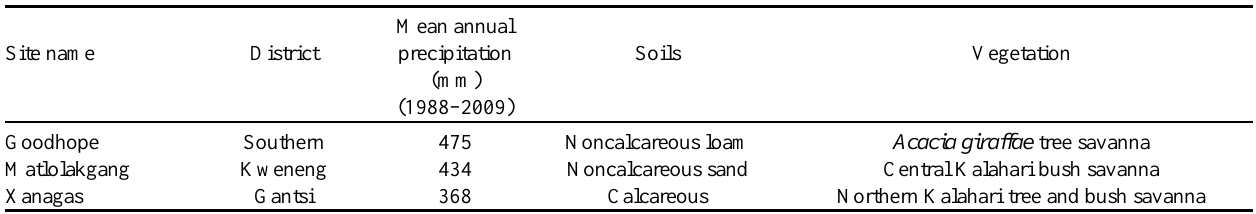
Table 1 . The biophysical features of the study sites.